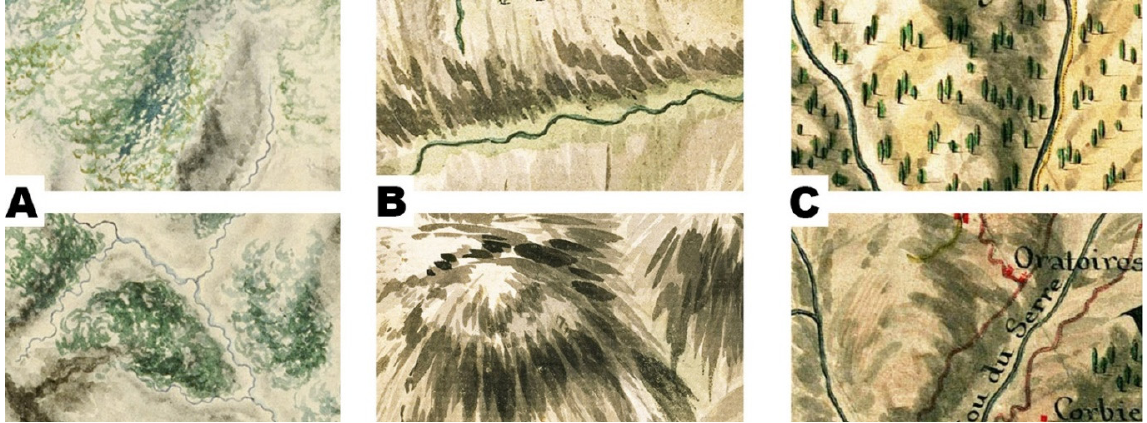
Figure 2. The painterly graphical means of expression in map details from Figure 1. ( A ): map of Sicily, ( B ): map of Scotland, and ( C ): map of Susa.